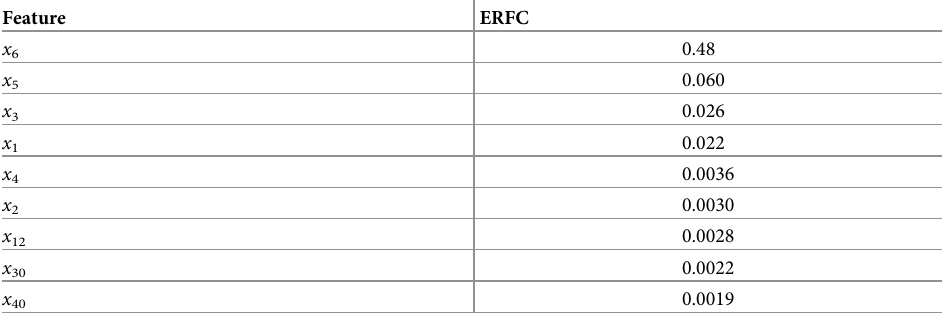
Table 1. The resulting ranking based on the expected relative feature contribution (ERFC) after having trained an XGBoost model consisting of six influential features ( x 1 − x 6 ) and 94 noise features ( x 7 − x 100